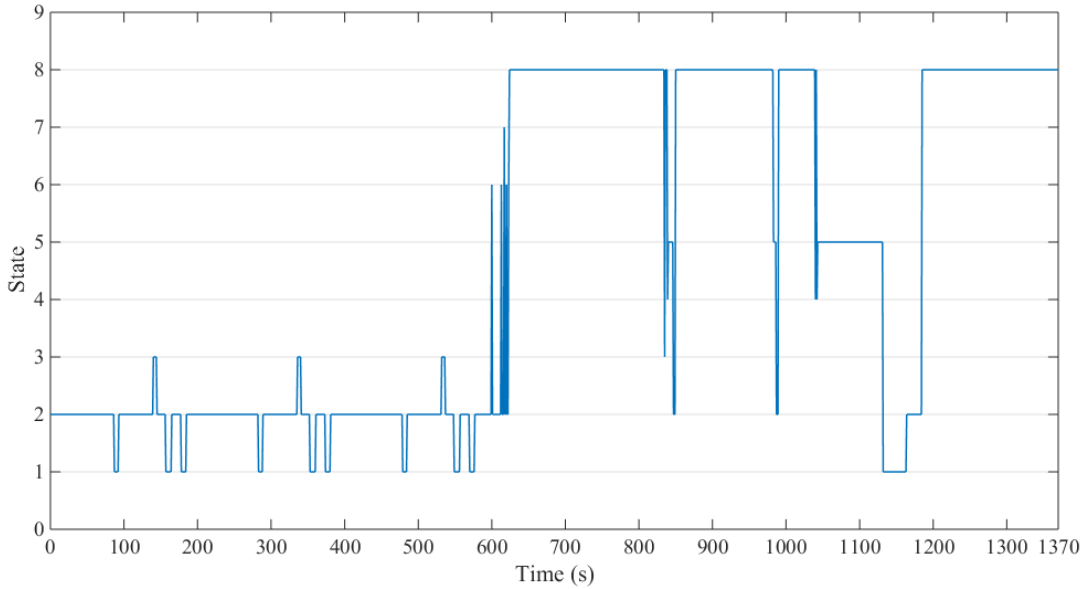
Figure 13. The state change of the switched energy management strategy.